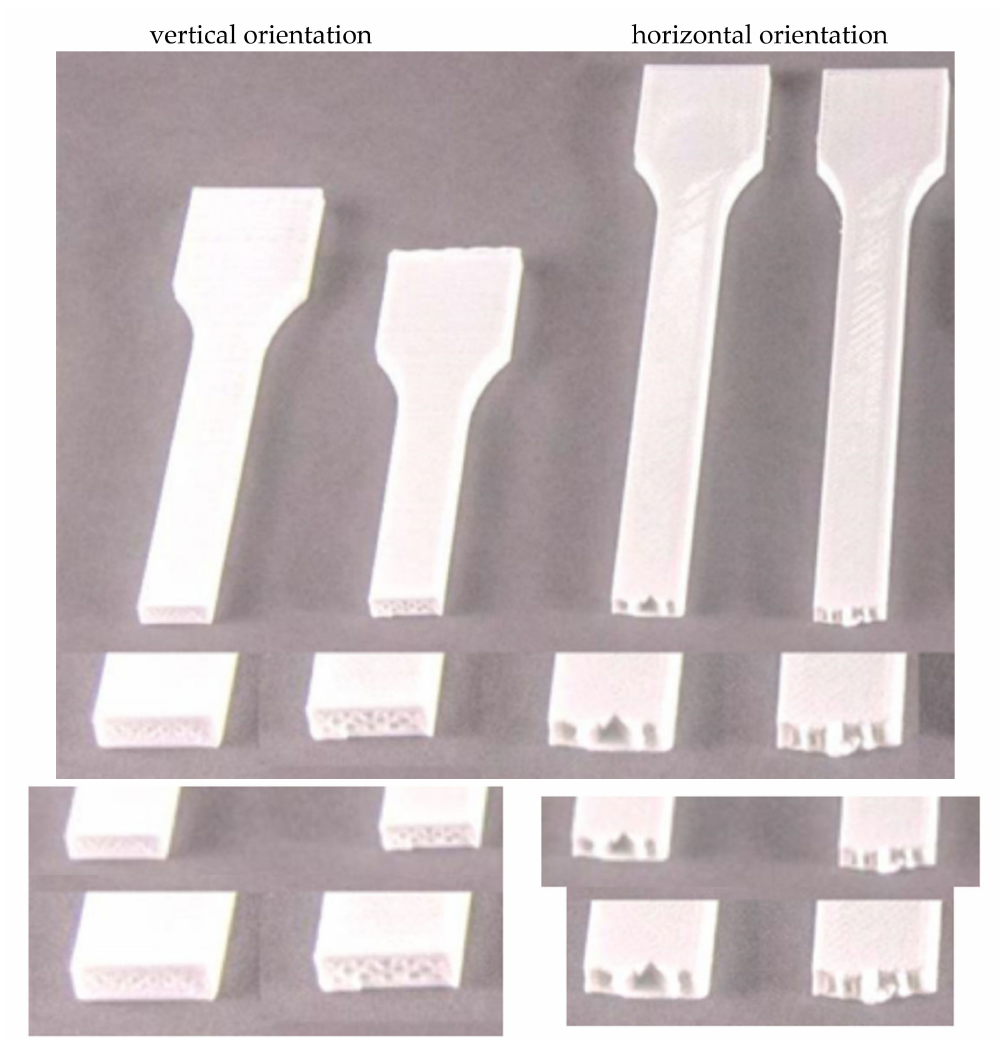
Figure 12. Comparison of the specimen breaking areas for horizontal and vertical